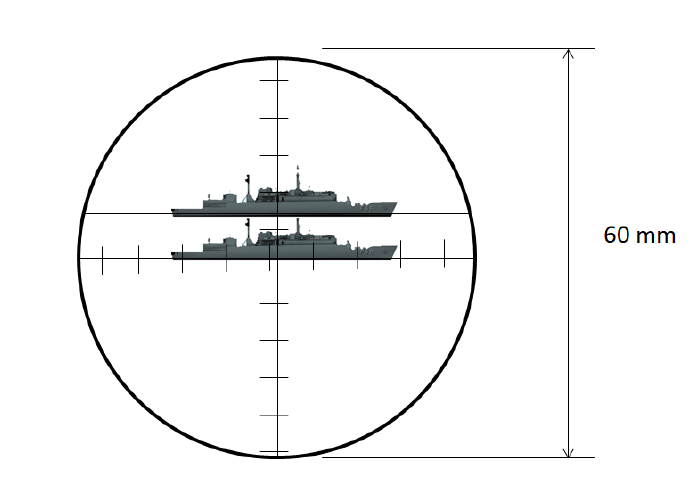
Figure 7. Typical stadiometer split